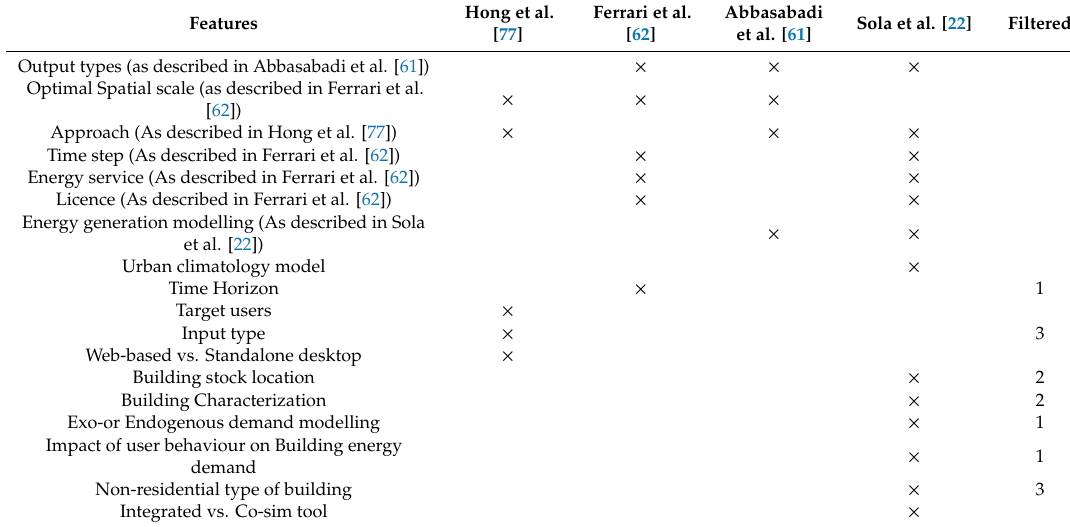
Table 1. List of selected and filtered urban building energy modelling (UBEM) tool